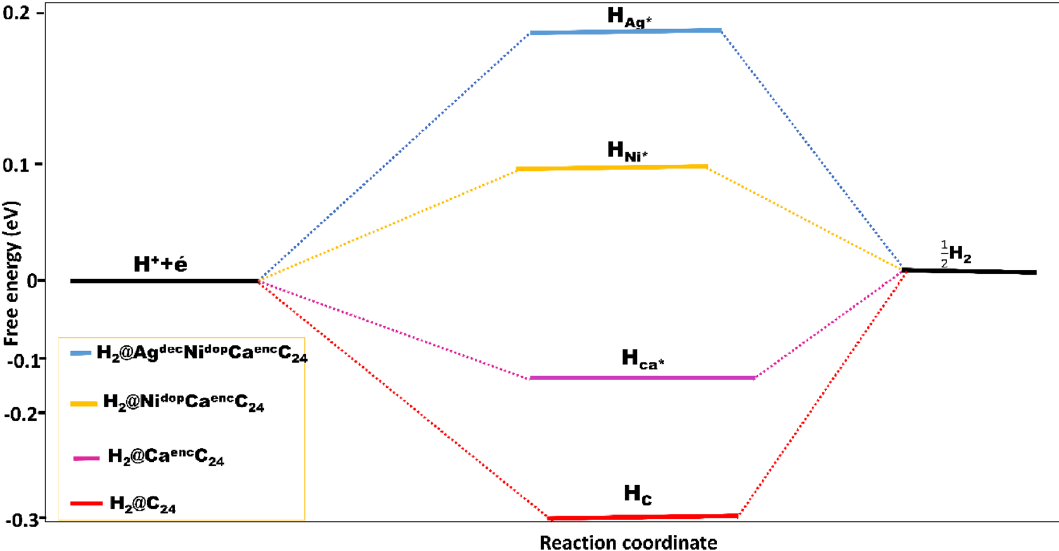
Figure 8. The Gibb’s free energy ( (cid:31) G H ) volcano-curve of the least to highest of the best adsorbed modeled systems (H c < H Ca* < H Ni* < H Ag*